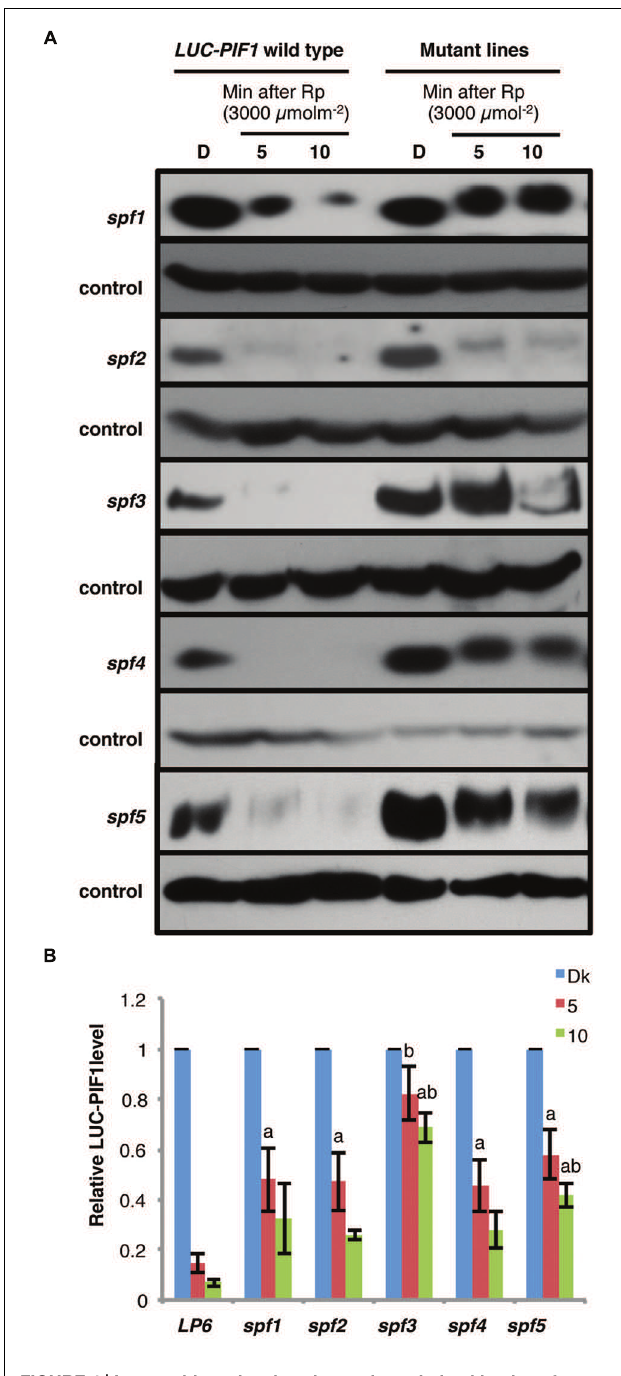
FIGURE 4 | Immunoblots showing slower degradation kinetics of LUC-PIF fusion proteins in the spf mutant lines compared to the LUC-PIF1 control. (A) Four-day-old dark-grown seedlings of the mutants and the LUC-PIF1 were either kept in darkness or given 3000 µ molm − 2 red light pulse followed by different durations of dark incubation as indicated above. The total protein of the mutants and the LUC-PIF1 were extracted from each time point and loaded into 6% SDS-PAGE gel for immunoblot analyses. The LUC-PIF1 fusion protein was detected by the primary antibody against luciferase and visualized using chemiluminescence method. (Continued)